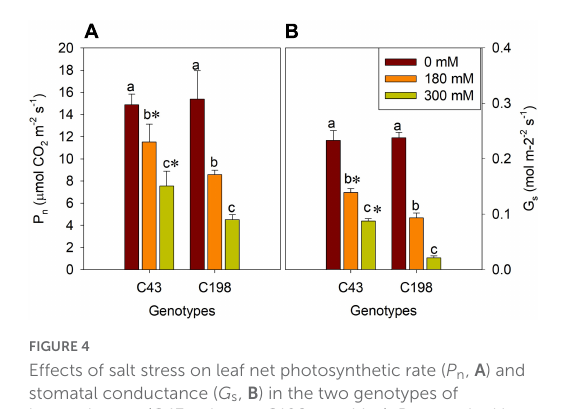
FIGURE4 Effects of salt stress on leaf net photosynthetic rate ( P n , A ) and stomatal conductance ( G s , B ) in the two genotypes of bermudagrass (C43, tolerant; C198, sensitive). Bars marked by the same letters are not significant at P < 0.05 (Tukey’s test) for the comparison of different salt concentrations within a given genotype. Bars marked with star (*) indicate significance at P < 0.05 (Tukey’s test) between the two genotypes at a given salt concentration. Data represent the mean ± SD of four independent biological